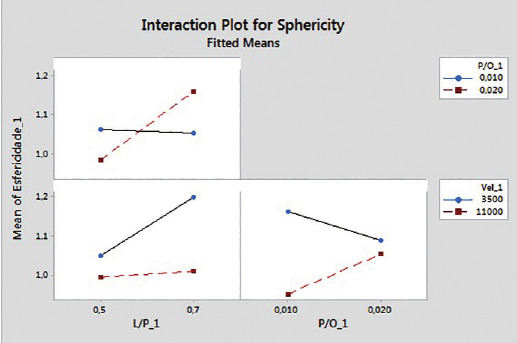
Figure 5: Interaction plot of the factors verified on the factorial